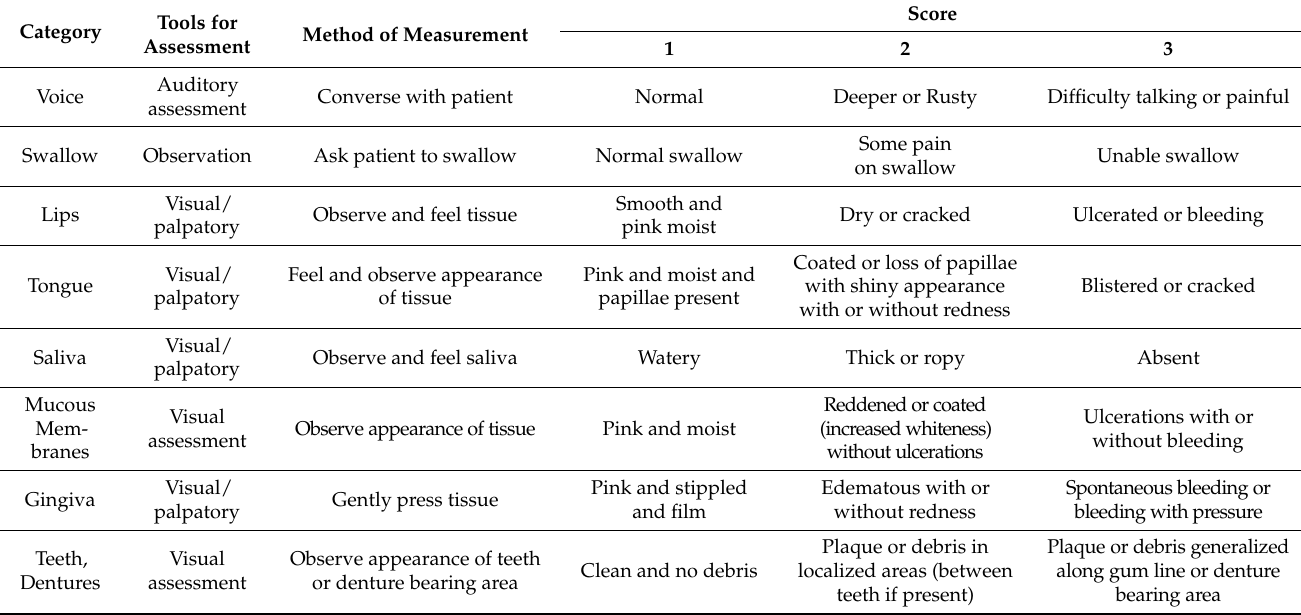
Table 1. Scores of the eight items in the